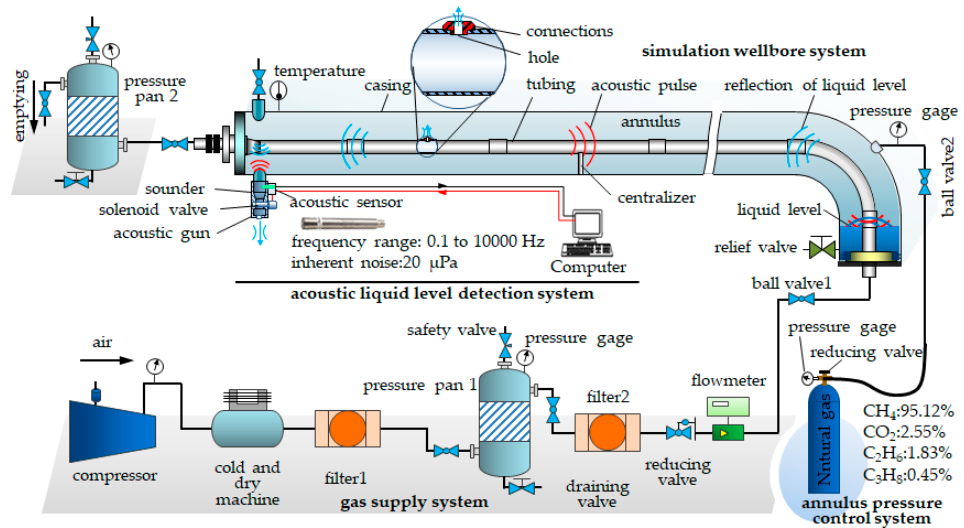
Fig ure 8. Experimental devices of the liquid level test. Figure 8. Experimental devices of the liquid level